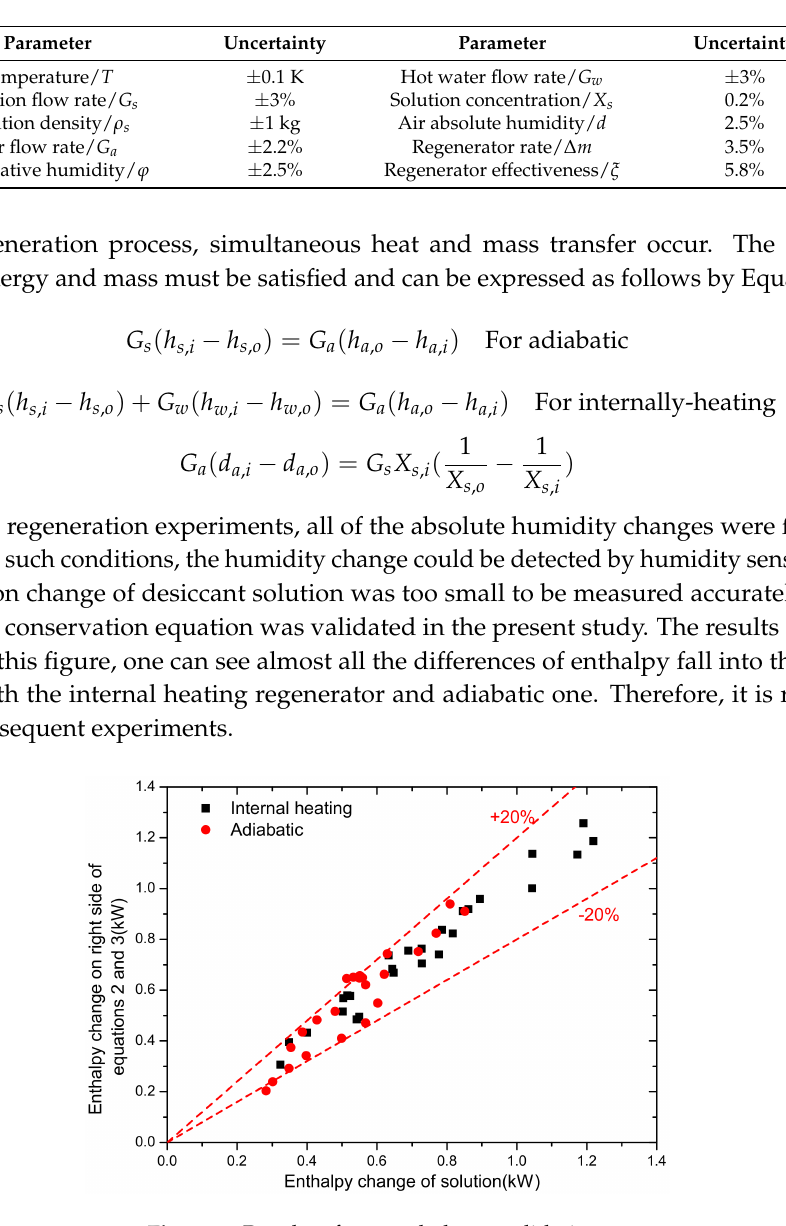
Table 1. Summary of parameters’ uncertainties.